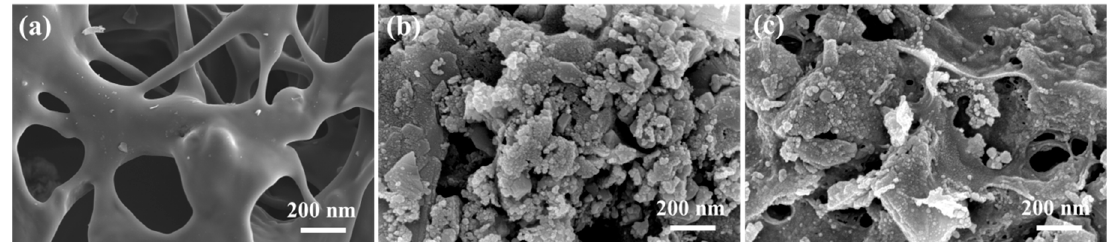
Figure 3. Field emission scanning electron microscopy (FESEM) images of ( a ) SC, ( b ) MR – FeS, and ( c ) MR – FeS@SC.